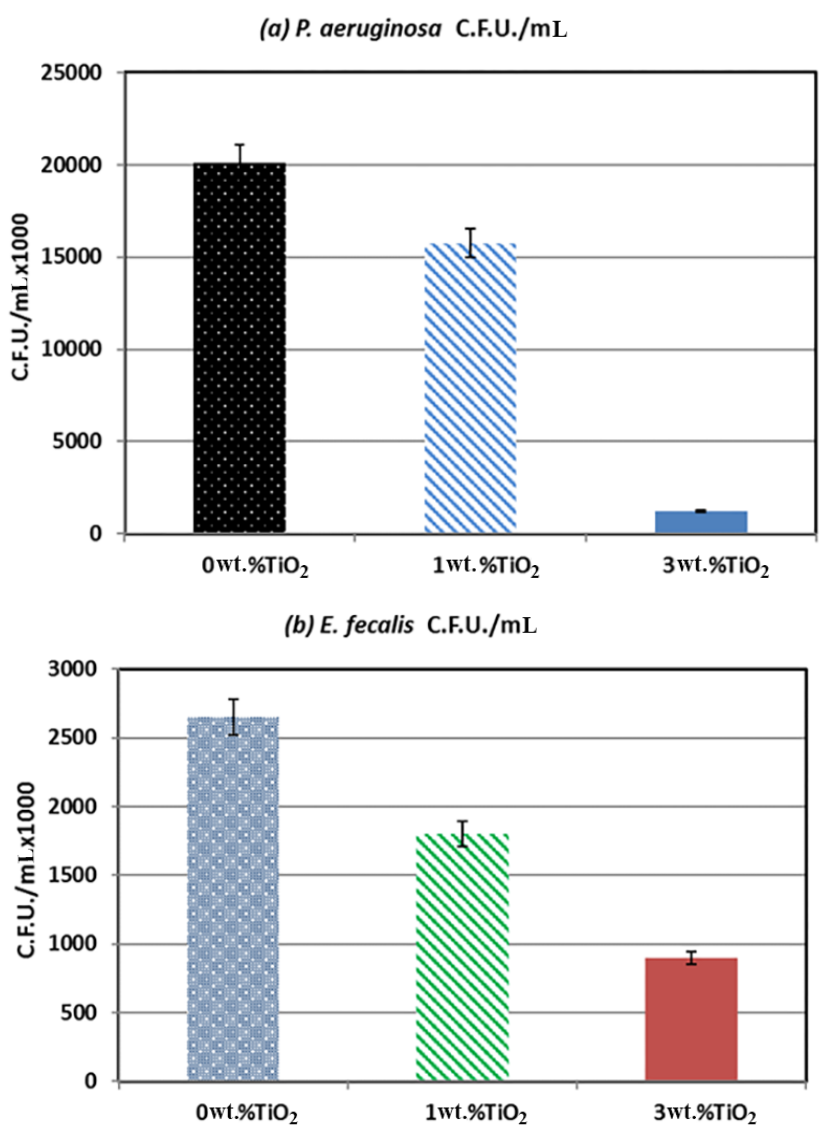
Figure 9. ( a ) Attachment of P. aeruginosa cells in colony forming units per mL (C.F.U./mL) to PMMA composites containing 0 wt. %, 1 wt. % and 3 wt. % TiO 2 . ( b ) Attachment of E. faecalis cells in C.F.U./mL to PMMA composites containing 0 wt. %, 1 wt. %, and 3 wt. % TiO 2 .